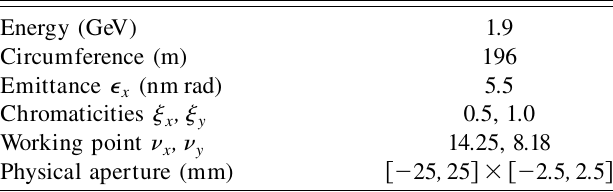
FIG. 16. (Color) ALS frequency map (a) and dynamic aperture (b): bare lattice at the location s (cid:1) 0 ( (cid:28) 4 : 0 m ). The orbit diffusion shows clearly the resonance network. Resonance chart (c): The working point is shown as a dashed line cross.